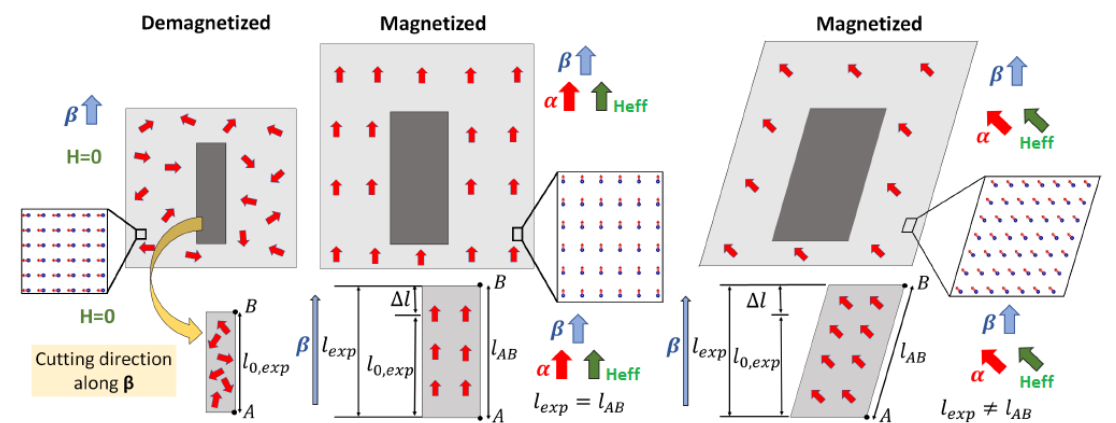
Figure 5. Schematic showing that if we cut the material along the measuring direction β and the effective magnetic field induces a normal deformation, then the length in the direction β , l exp , given by Equation (15), is equal to the total length l AB defined as the distance between the new positions of points A and B in the deformed material. However, if the field induces a shearing deformation then l exp is not equal to l AB